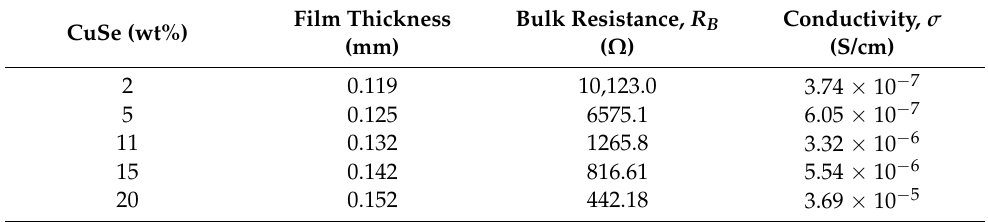
Table 1. Electrical properties of CH/Na/CuSe polymer matrix with different wt% of CuSe